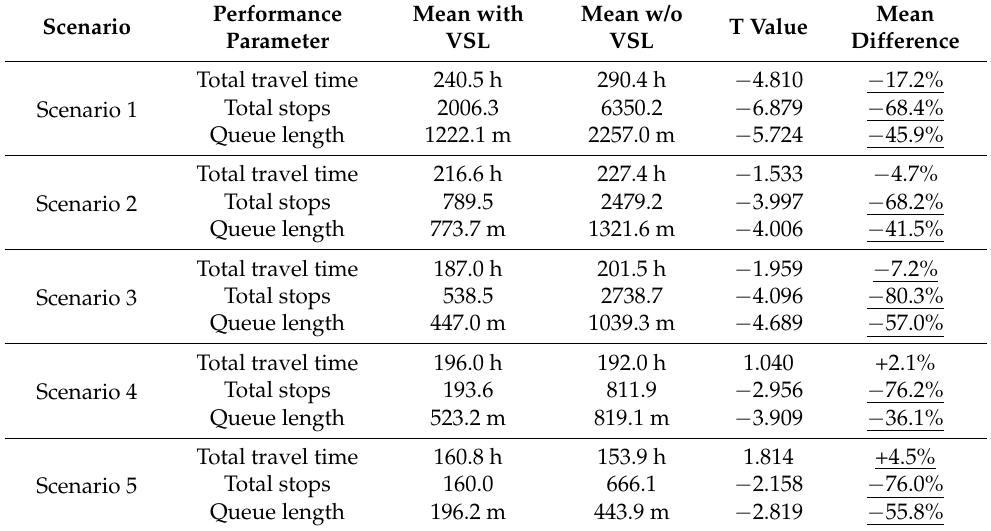
Table 3. Microsimulation results and